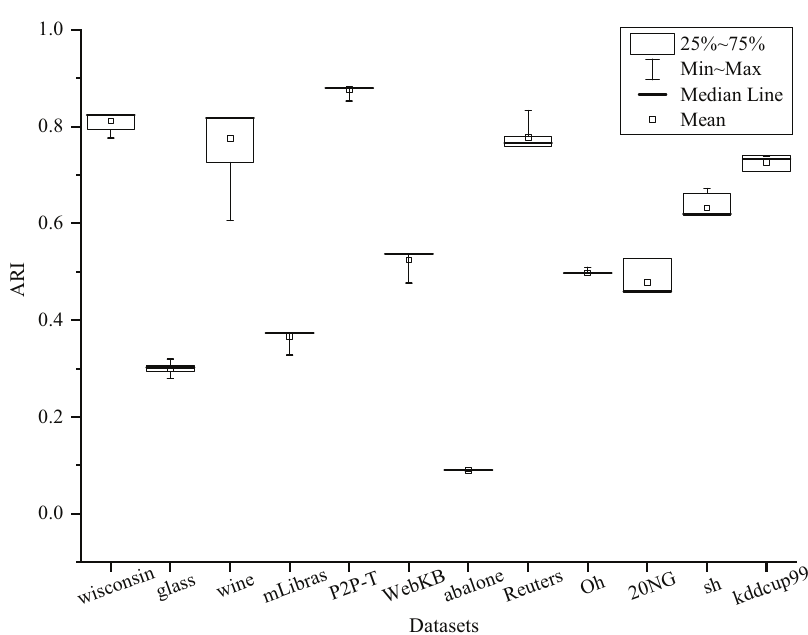
Figure 4. Sensitive analysis by variations of ARI with respect to η 1 ∈ [ − 0.8,0.9 ] with step